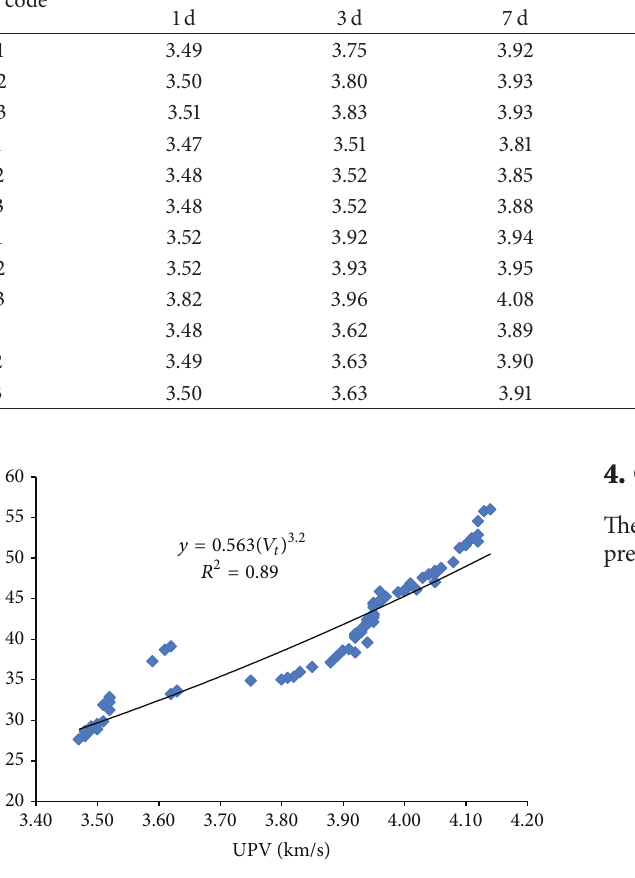
Figure 12: Relationship between compressive strength and ultra- sonic pulse